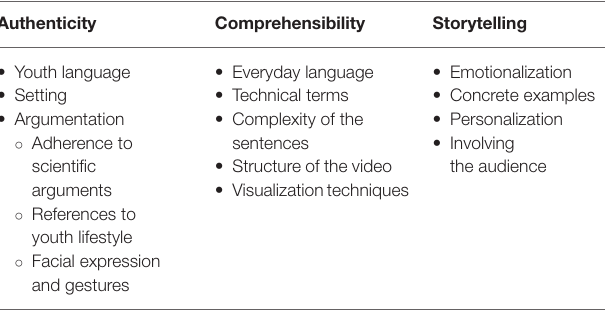
TABLE 3 | Category system for the analysis of the video transcripts.